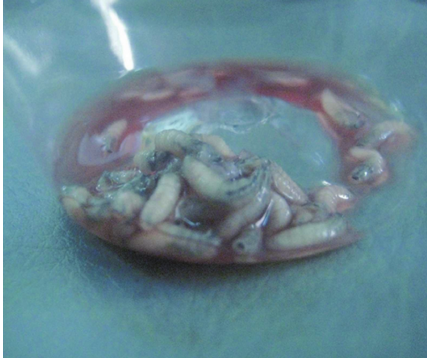
Figure 2: Postoperative picture showing maggots after removal from the infected